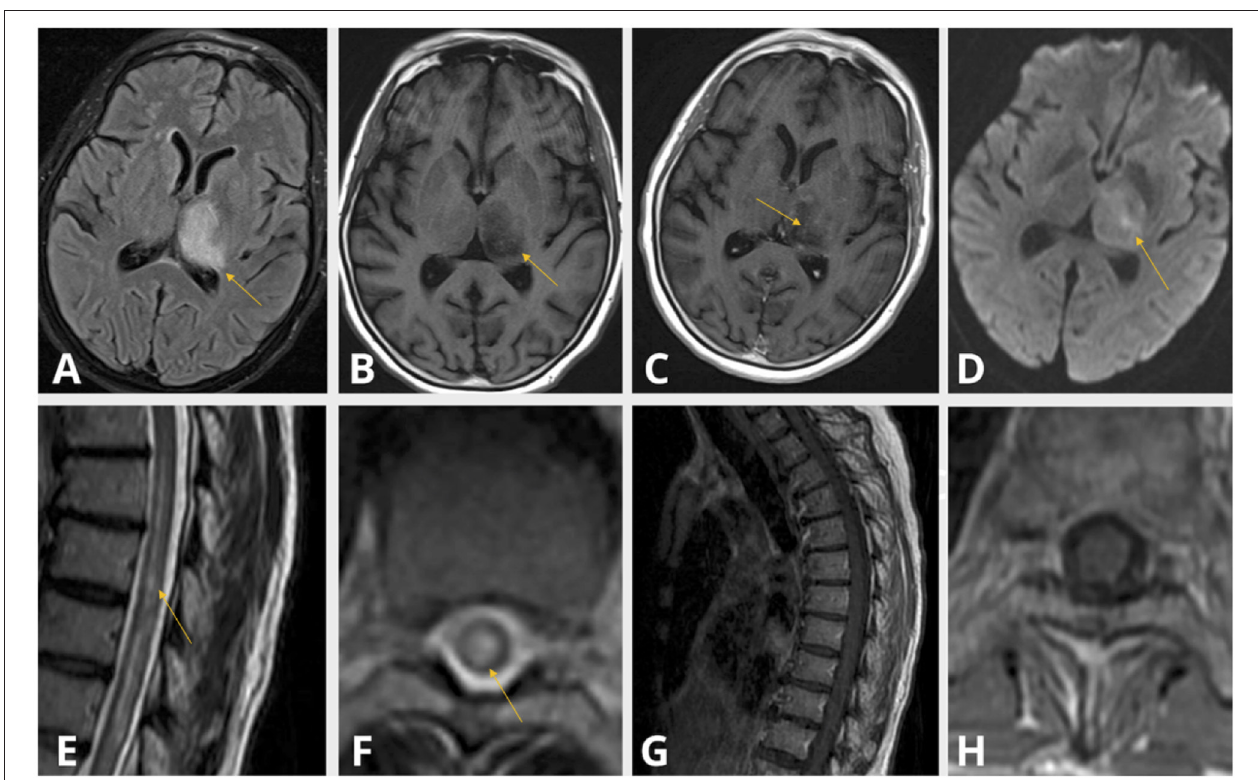
FIGURE 3 | Case 2: Thalamic T2 FlAIR hyperintensity (A) , T1 shortening (B) with subtle contrast enhancement (C) and diffusion restriction (D) . Centrally located T2 hyperintensity spanning the length of the thoracic cord (E,F) without evidence of contrast enhancement (G,H) .